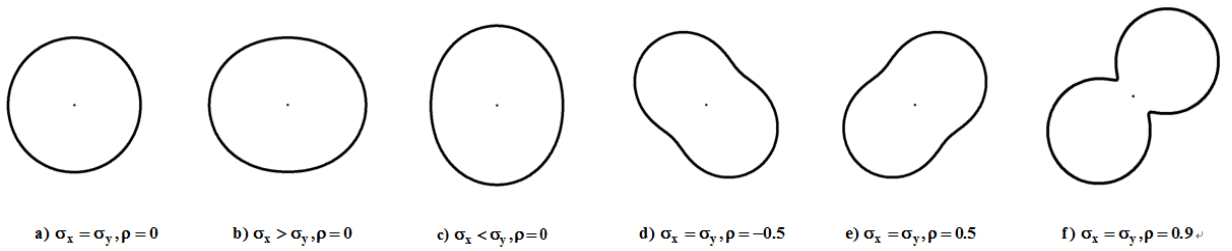
Figure 1. Analytical GPS error model (standard error